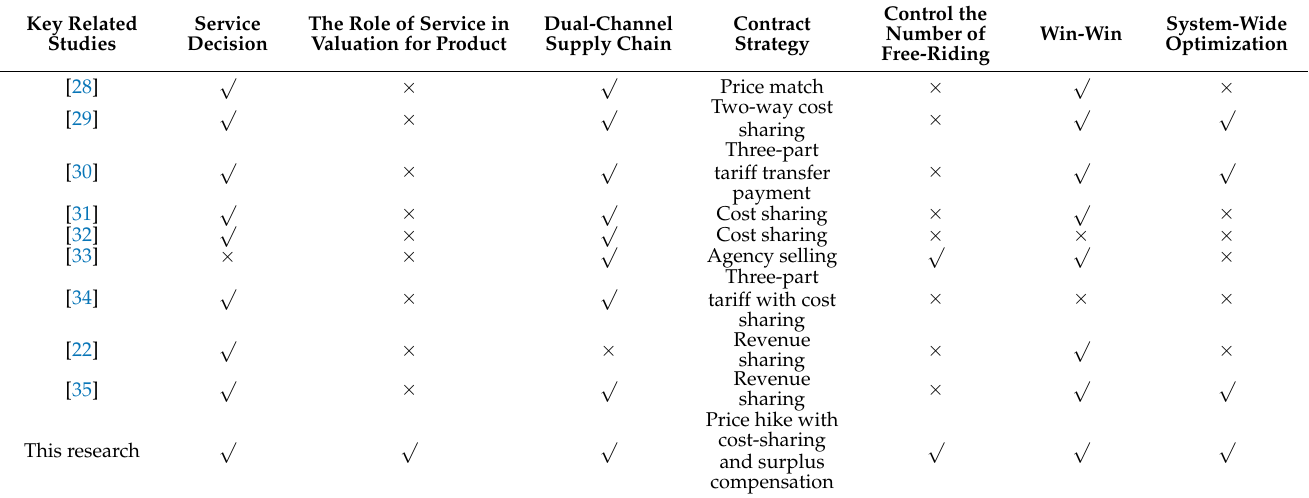
Table 1. List of key studies related to this